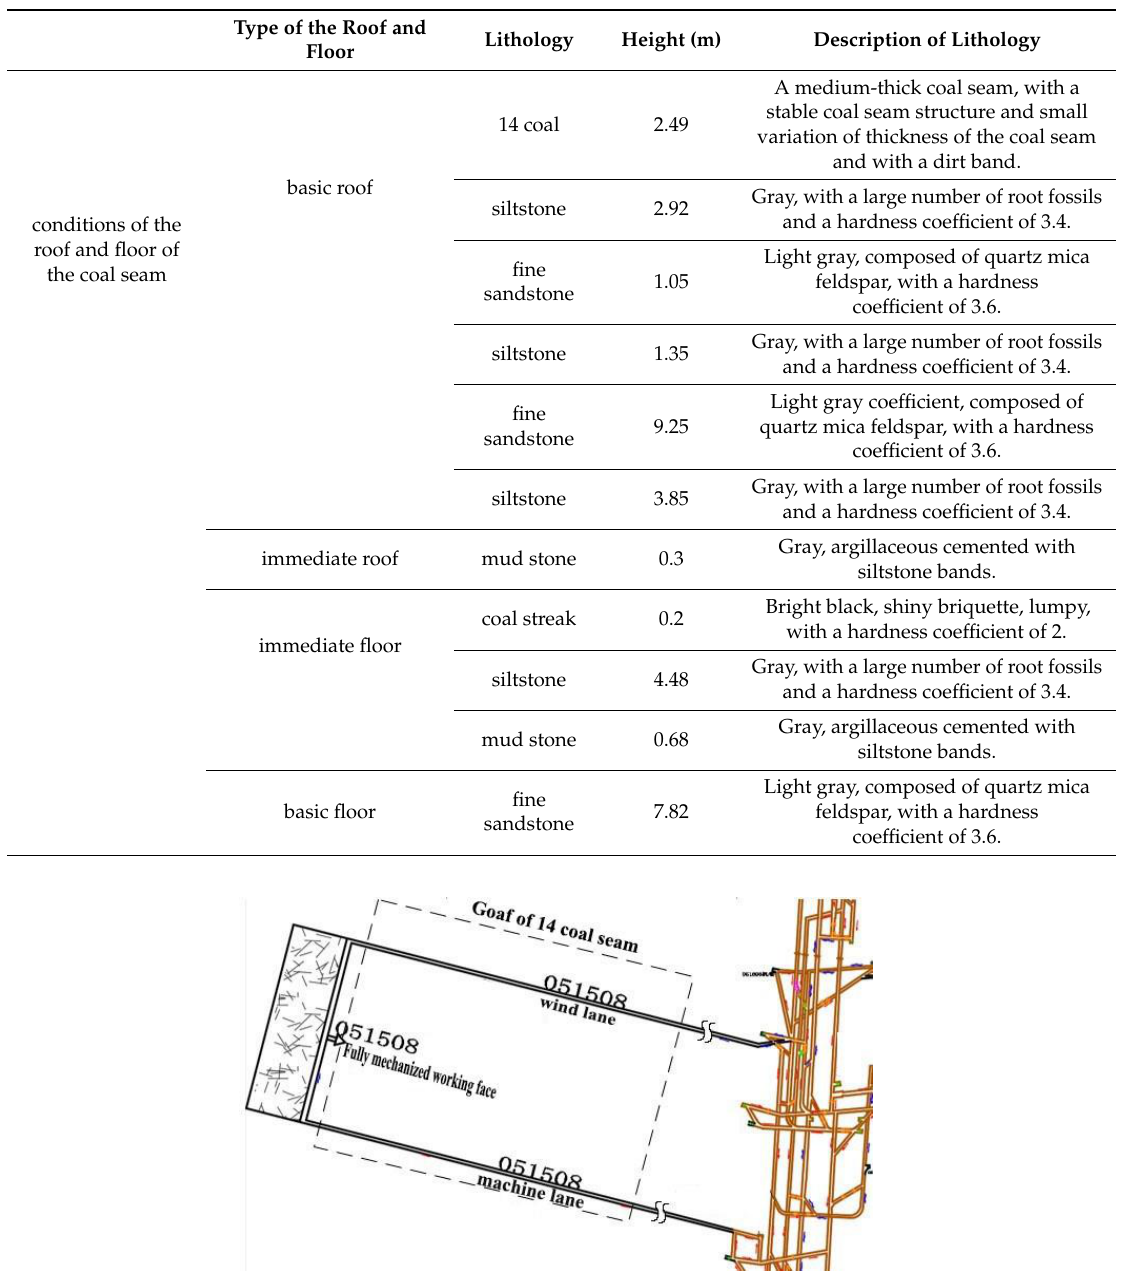
Table 1. Lithology of the roof and the floor of the coal seam.